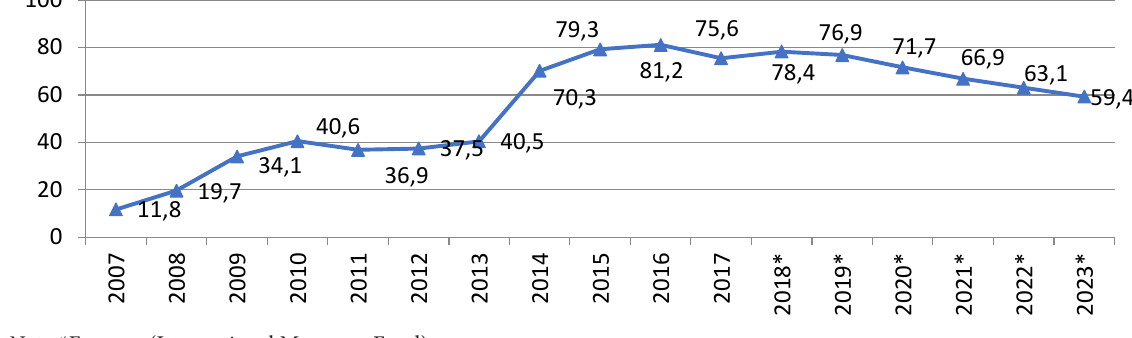
Figure 5. Government debt of Ukraine in relation to GDP,